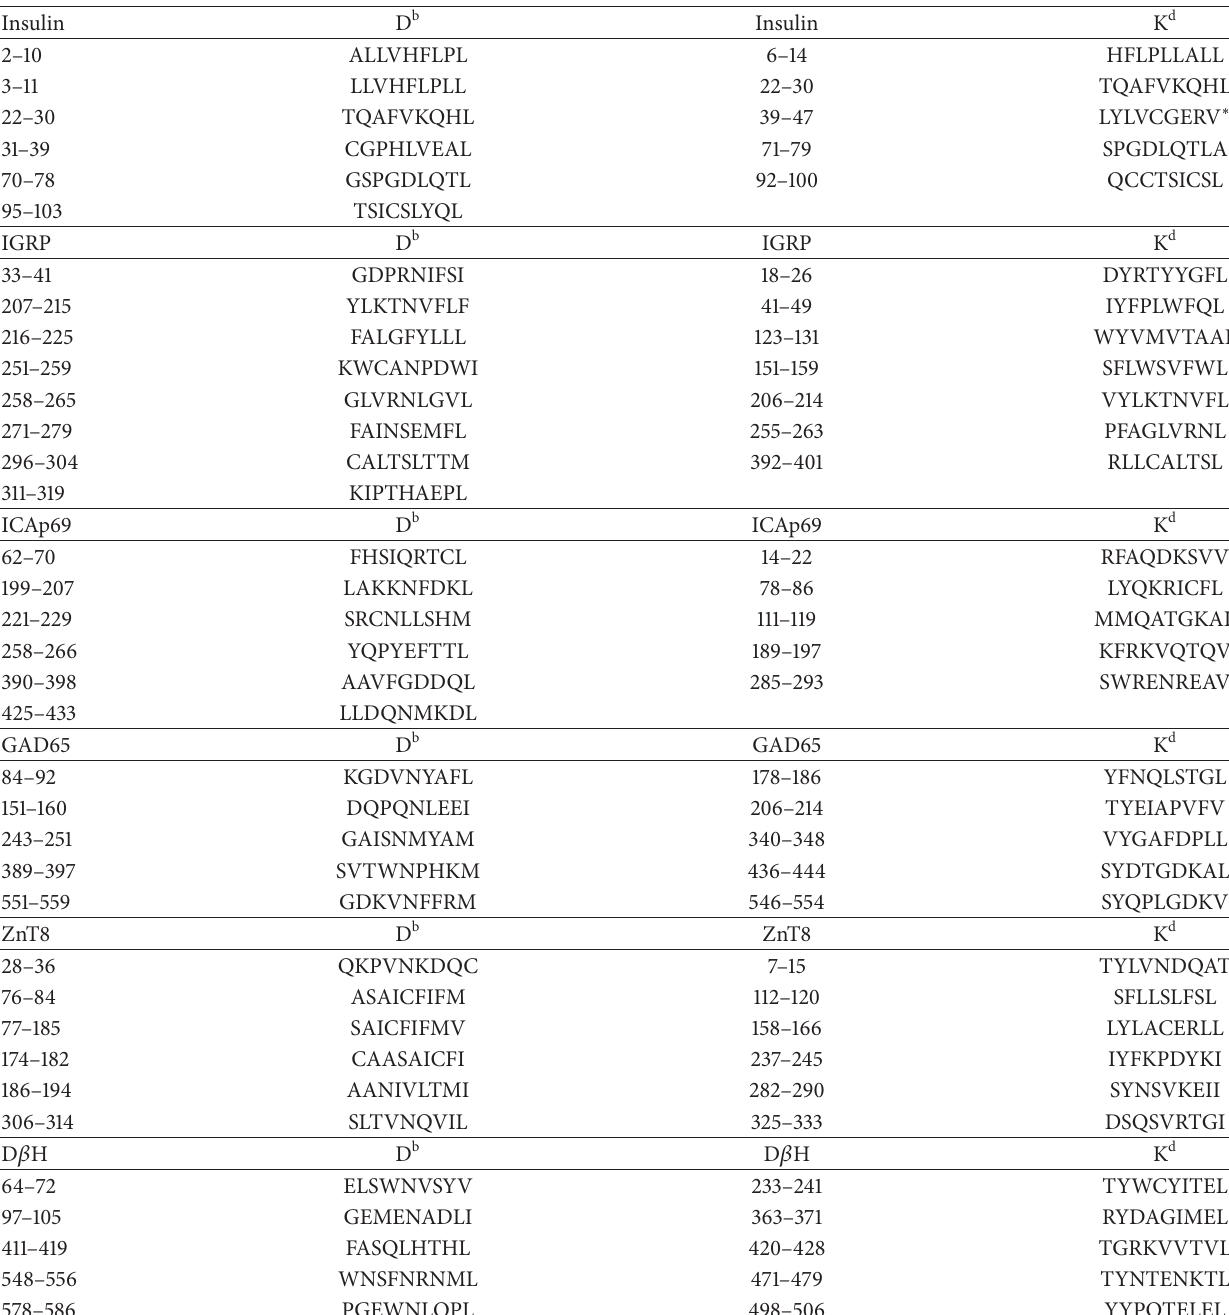
Table 1: The amino acid numbers of the primary translation product of each peptide are indicated. Asterisk for insulin 39 acid substitution (G > V) at position 9 that was shown to enhance MHC binding stability